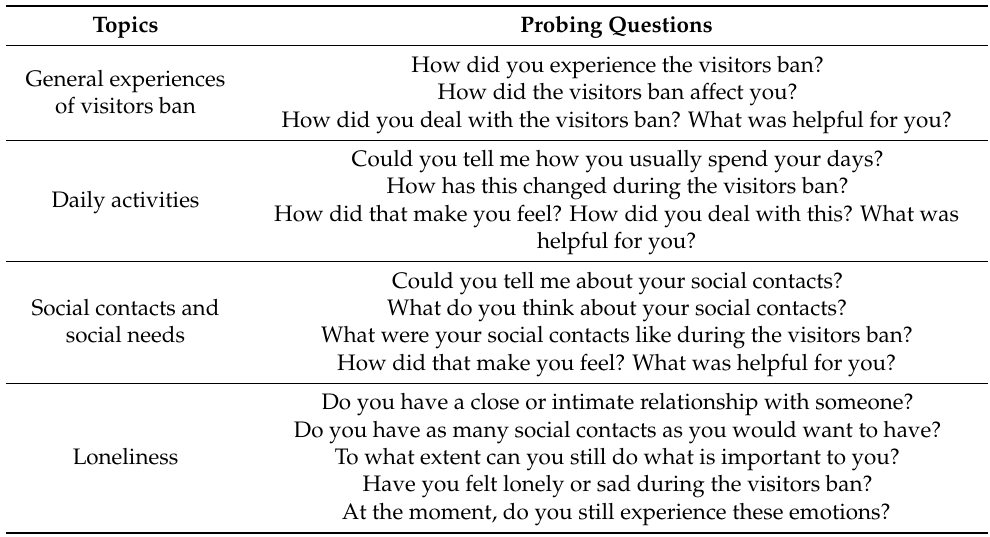
Table A1. Semi-structured interview guide for interviews with residents and close